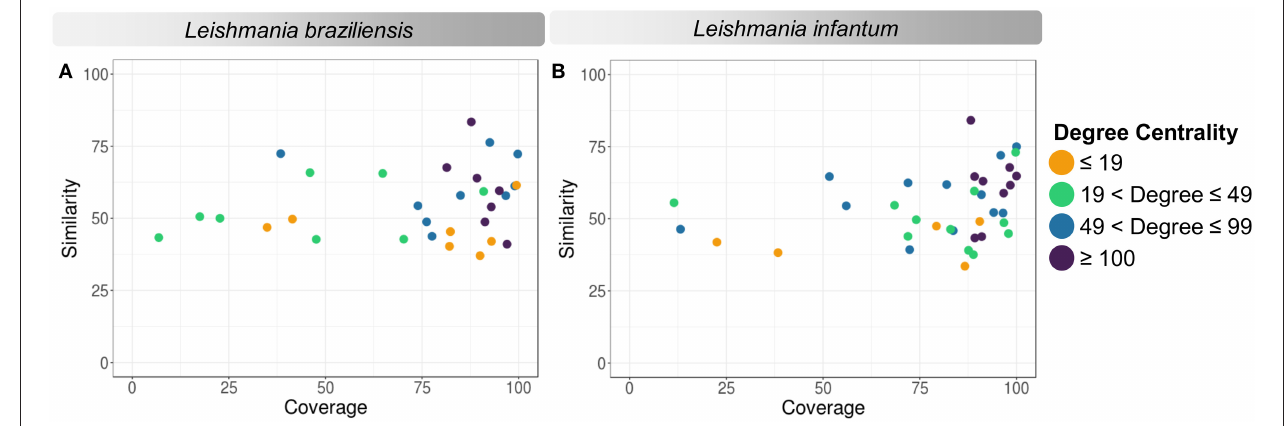
FIGURE 4 | Degree centrality, similarity, and coverage against human proteome of potential target proteins of Leishmania sp. (A) Leishmania braziliensis ; (B) Leishmania infantum . The degree centrality of each protein is reflected in orange (degree ≤ 19), green (19 < degree ≤ 49), blue (49 < degree ≤ 99), and purple (100 ≤ degree).